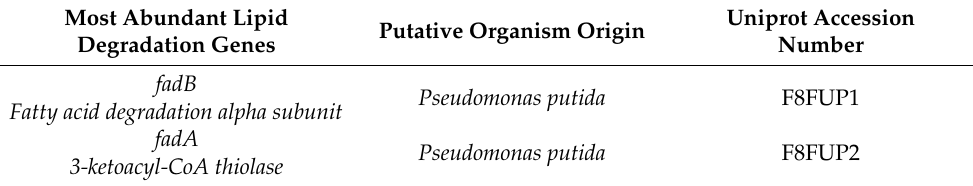
Figure 4. M. algicola OT MT023716 growth on lipids and other sources. Table 3. BWA alignment results of lipid degradation genes with raw genomics reads from 19 O. tauri (and its phycosphere) line cultures. From these 19 independent lines, which were endpoints diluted through serial subcultures [41], all the cultivable bacteria in solid media were determined to be M. algicola OT MT023716 [25]. Here, the most abundant lipid degradation genes found from the genomic screening of the culture data are presented.